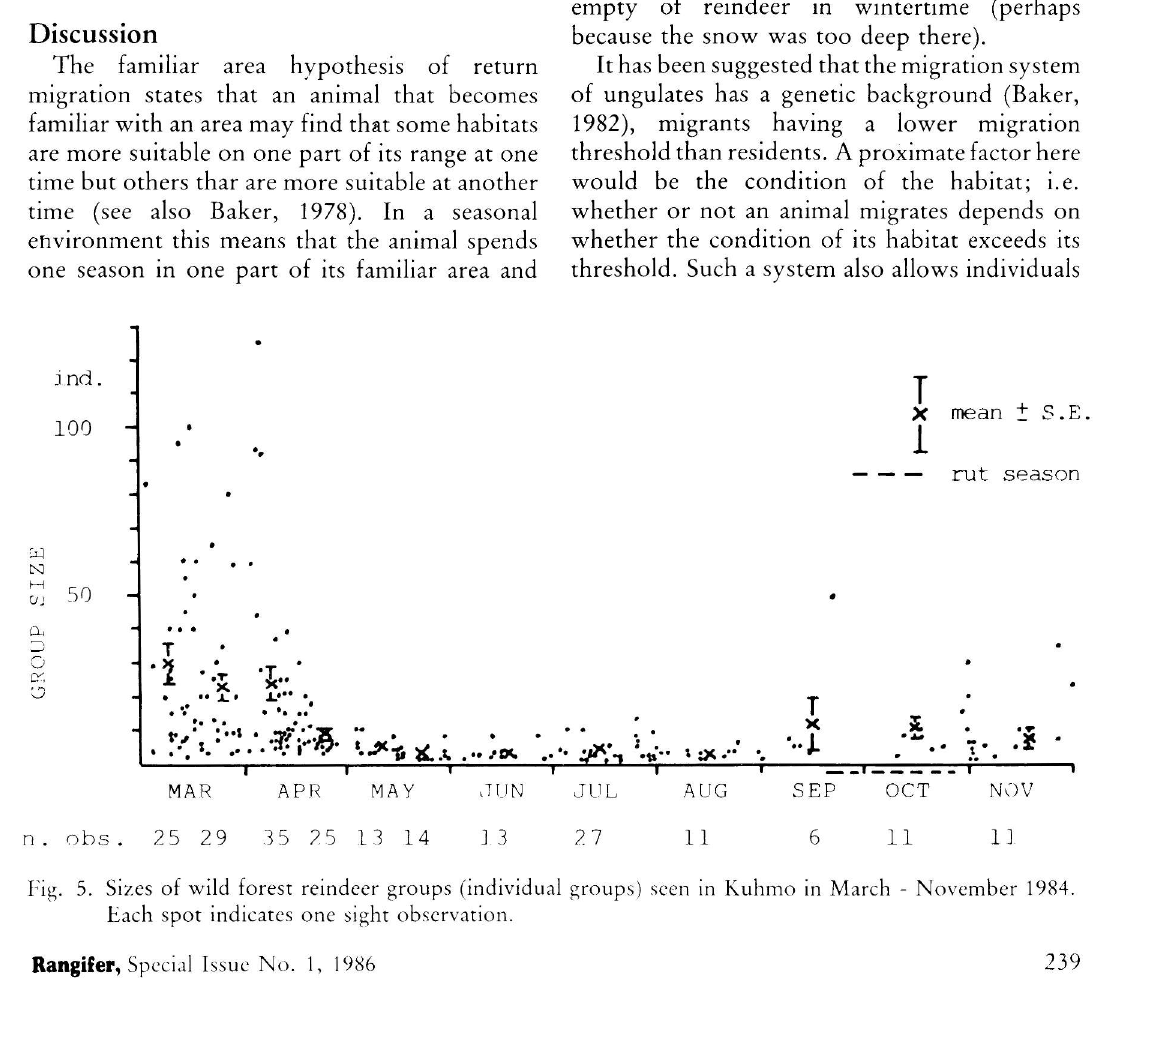
Fig. 4. Mean daily moving speeds (A) of radio- tracked wild forest reindeer in Kuhmo in April - November. The values are calculated as means of distances (on map) between consecutive radiolocations during 5-day periods and they thus represent, in fact, minimum average speed (km/day). B shows the maximum speed recorded during each 5-day period.